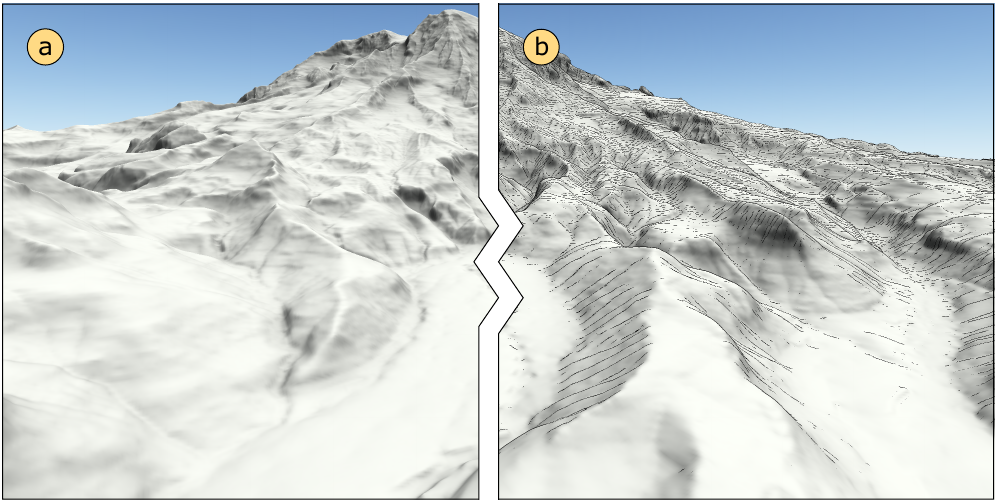
Figure 5. Shaded surfaces ( a ) can be extended with enhanced edges ( b ) to emphasize contour-based features of the